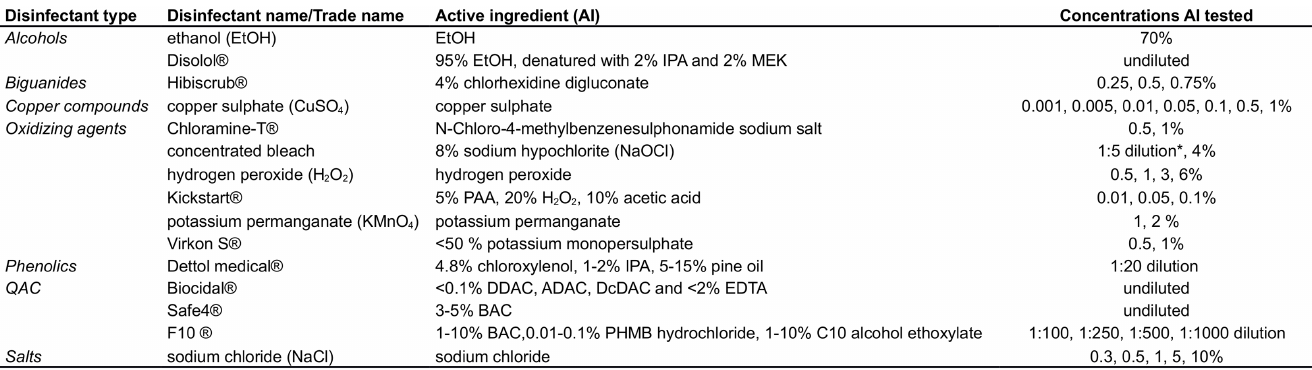
Fig 1. Overview of the disinfectants and the concentration of their active ingredients (AI) tested. ADAC: C12-C16-alkyl dimethyl ammonium chloride,BAC: benzalkonium chloride,DDAC: didecyldimethyl ammoniumchloride, DcDAC: dicoco dimethyl ammoniumchloride,EDTA: ethylenediaminetetraacetic acid, IPA: isopropylalcohol,MEK: methyl ethyl ketone, PAA: peracetic acid, PHMB: polyhexamethylene biguanide,QAC: quaternaryammoniumcompounds; * 1/5 dilution or 1.6% NaOCl: recommended dilutionfor household purposes.